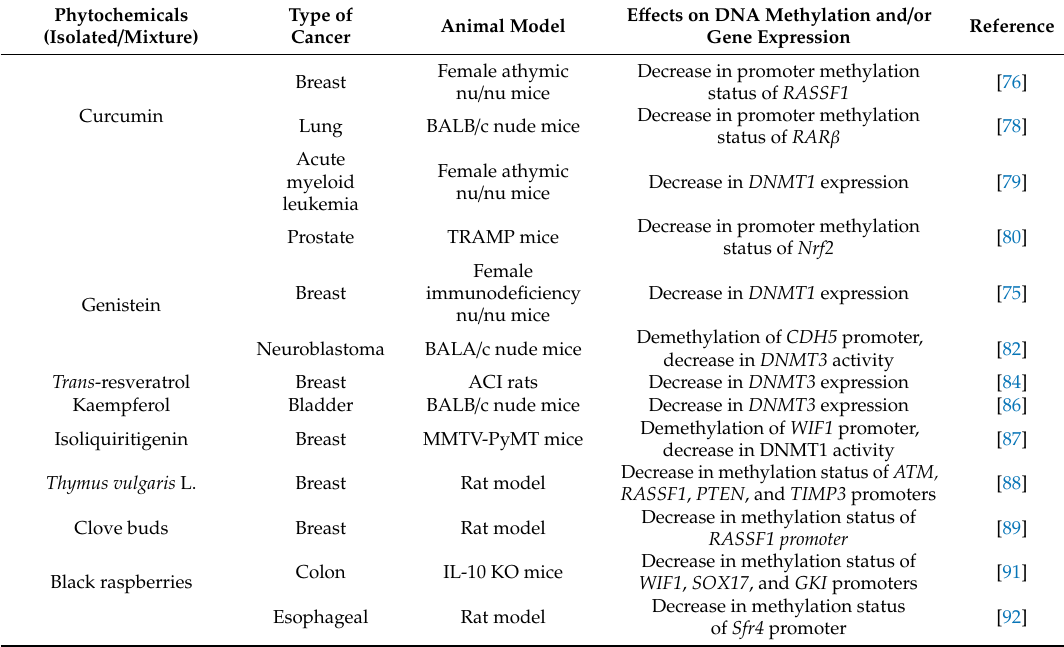
Table 2. Phytochemicals targeting DNA methylation in cancer animal model studies. Phytochemicals (Isolated /